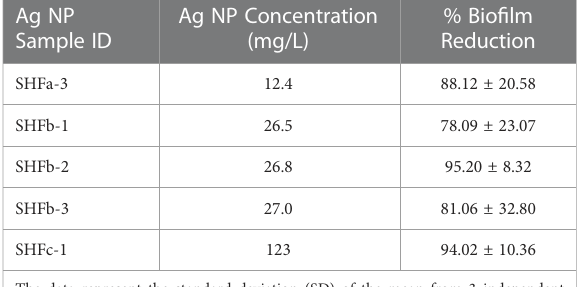
TABLE 1 Results of percent bio fi lm reduction in initial